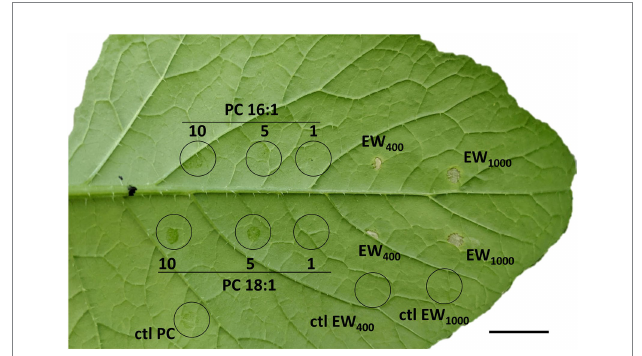
FIGURE 7 Phosphatidylcholines (PC) does not induce HR-like cell death in B. nigra plants unlike P. brassicae egg wash. Brassica nigra (SF48-O1) plants were treated with phosphatidylcholines PC(16:1/16:1) and PC(18:1/18:1) or with egg wash (EW). PCs were solubilized in 1% DMSO, 0.5% Glycerol and 0.1% Tween and were applied at different concentrations (1, 5, and 10 μ g/ μ L). A solution of 1% DMSO, 0.5% Glycerol and 0.1% Tween was used as control (ctl). Egg wash 400 was prepared with 400 eggs/mL, egg wash 1000 was prepared with 1,000– 1,200 eggs/1 mL. All treatments were applied on the same leaf, with two leaves per plant, on 15 biological replicates. Scale bar =